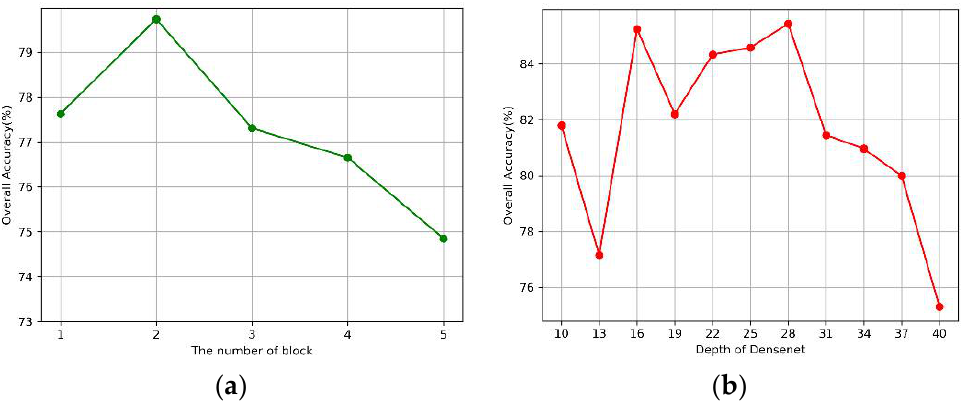
Figure 7. The impact of the original DenseNet. ( a ) Blocks, ( b ) Depth of the network.